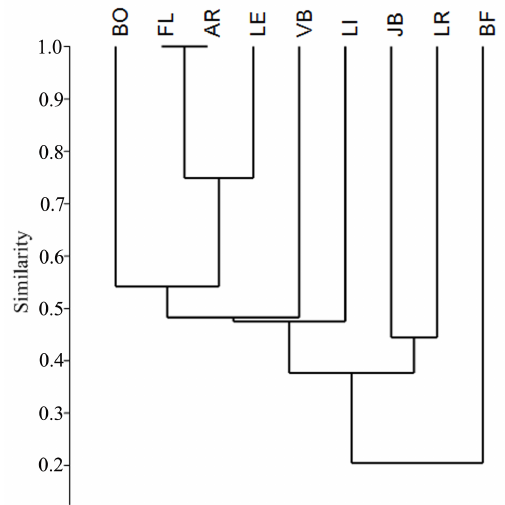
Figure 6. Similarity of the epiphytic and epilithic algae composition (Simpson Index) in nine urban eutrophic ponds from Goiânia,